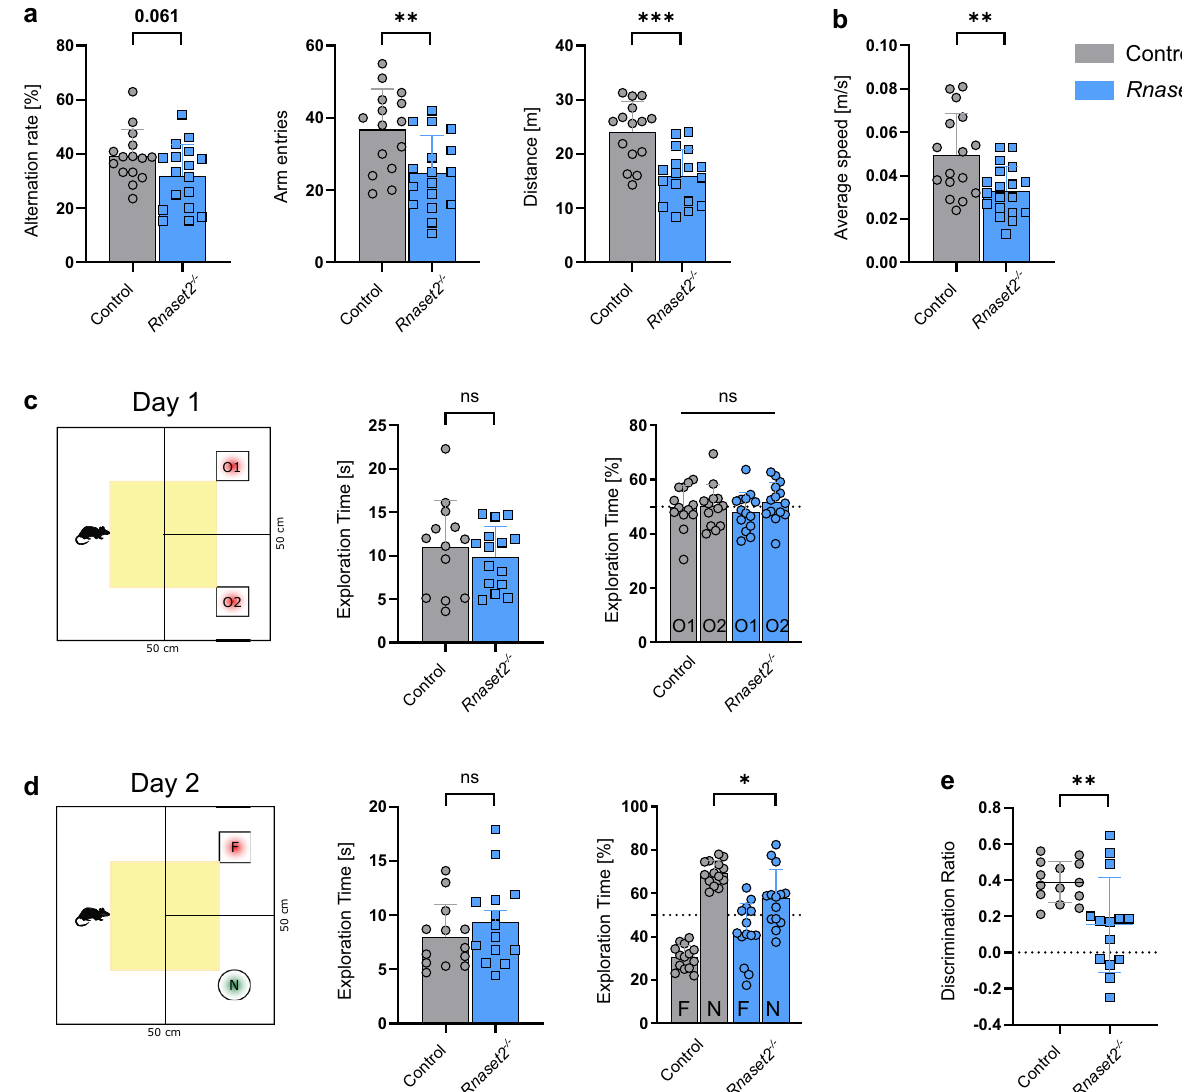
Fig. 6 Memory impairment in 4-month-old Rnaset2 − / − mice. a Cross maze testing: Percentage of spontaneous alternation ( p = 0.061), total arm entries, and the average distance in meters of Rnaset2 − / − (blue) and control mice (gray). Rnaset2 − / − mice showed less activity, documented by a reduced number of arm entries ( p = 0.0034) combined with a signi fi cant decrease of the average distance ( p = 0.0001) covered in the cross maze. b Graph depicting the signi fi cantly reduced average speed of Rnaset2 − / − compared to control mice in the open fi eld box ( p = 0.0031). c Novel object recognition (NOR) analysis in an open fi eld box. Mean percentage of time spent exploring two similar objects (O1 and O2, red) and total exploration time on training day (Day 1) were similar in both genotypes. d Mean percentage of time spent exploring two different objects, the familiar (F, red) and a novel one (N, green), on testing day (Day 2) of the NOR test was signi fi cantly different between Rnaset2 − / − mice and controls ( p = 0.0456). e Discrimination ratio of Rnaset2 − / − mice was signi fi cantly diminished ( p = 0.0046). Rnaset2 − / − n = 17, control n = 15. Values are given as the mean ± SEM. Statistical analysis was performed with unpaired t-test and with two-way ANOVA followed by Tukey´s multiple comparison test. p values are represented as **** p < 0.0001, *** p < 0.001, ** p < 0.01, * p < 0.05 and not signi fi cant (ns) p ≥ 0.05. Source data are provided as a Source data fi functional consequences of type I interferon-triggered pathways within the CNS will have far-reaching implications not only for inborn RNaseT2-de fi cient CLE and AGS but also for congenital viral infections. As such, it may be useful to facilitate the design of therapeutic approaches for these severe early childhood onset diseases.